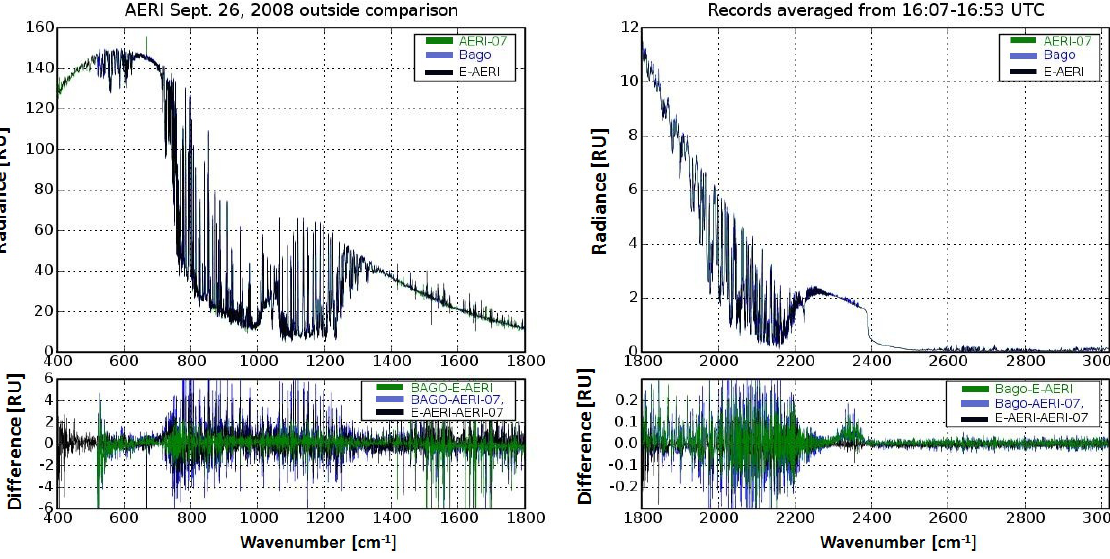
Fig. 4. Radiance measurements during two outside side-by-side tests performed at UW. Top panels display measured radiance (RU=mW/(m 2 srcm − 1 )) with residuals in the bottom